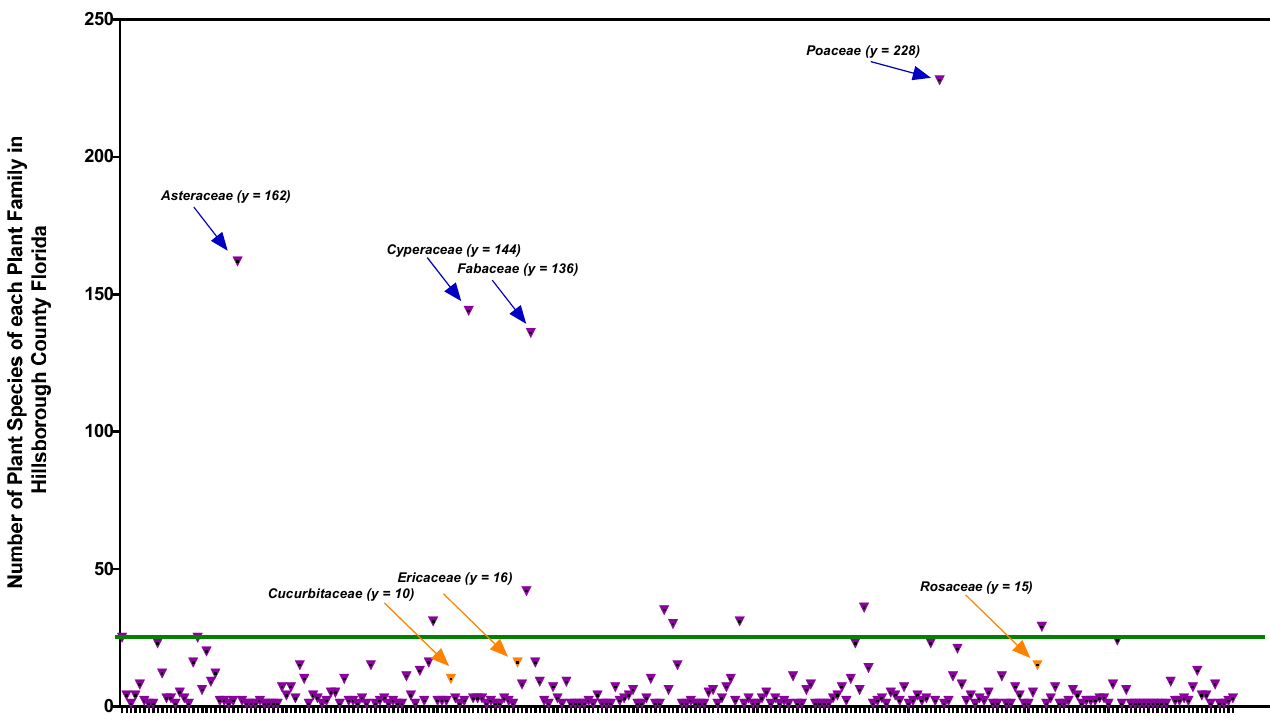
Figure 1. The number of plant species of each plant family identified in Hillsborough County, Florida, United States. The triangles represent plant families; the blue arrows point to plant families with the highest number of species; the orange arrows point to plant families selected in this article.